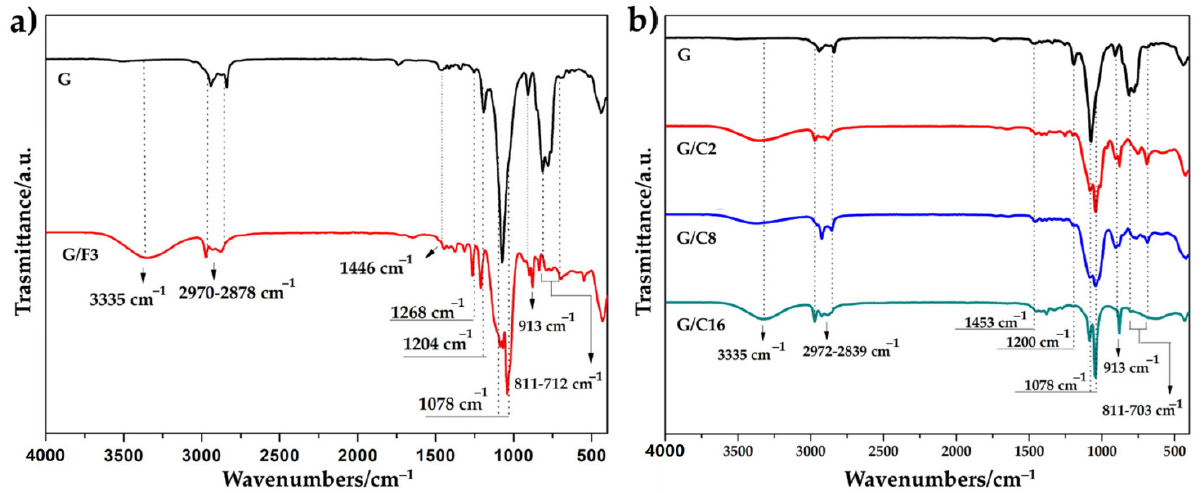
Figure 6. FT-IR spectra of glass slides treated with G and G/F3 sol ( a ) and G/C2, G/C8 and G/C16 sol ( b ). sol ( b